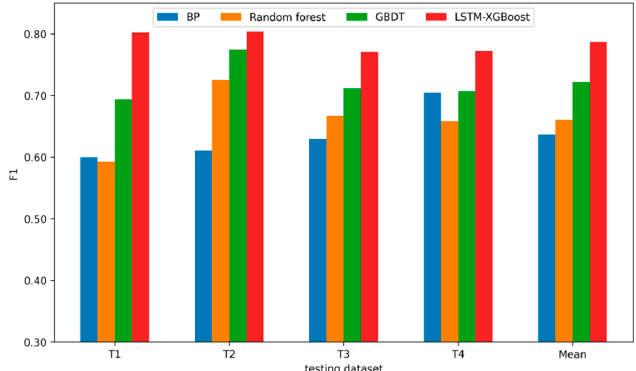
Figure 13. Recall rate R of heavy overload prediction models of public transformer based on each algorithm.